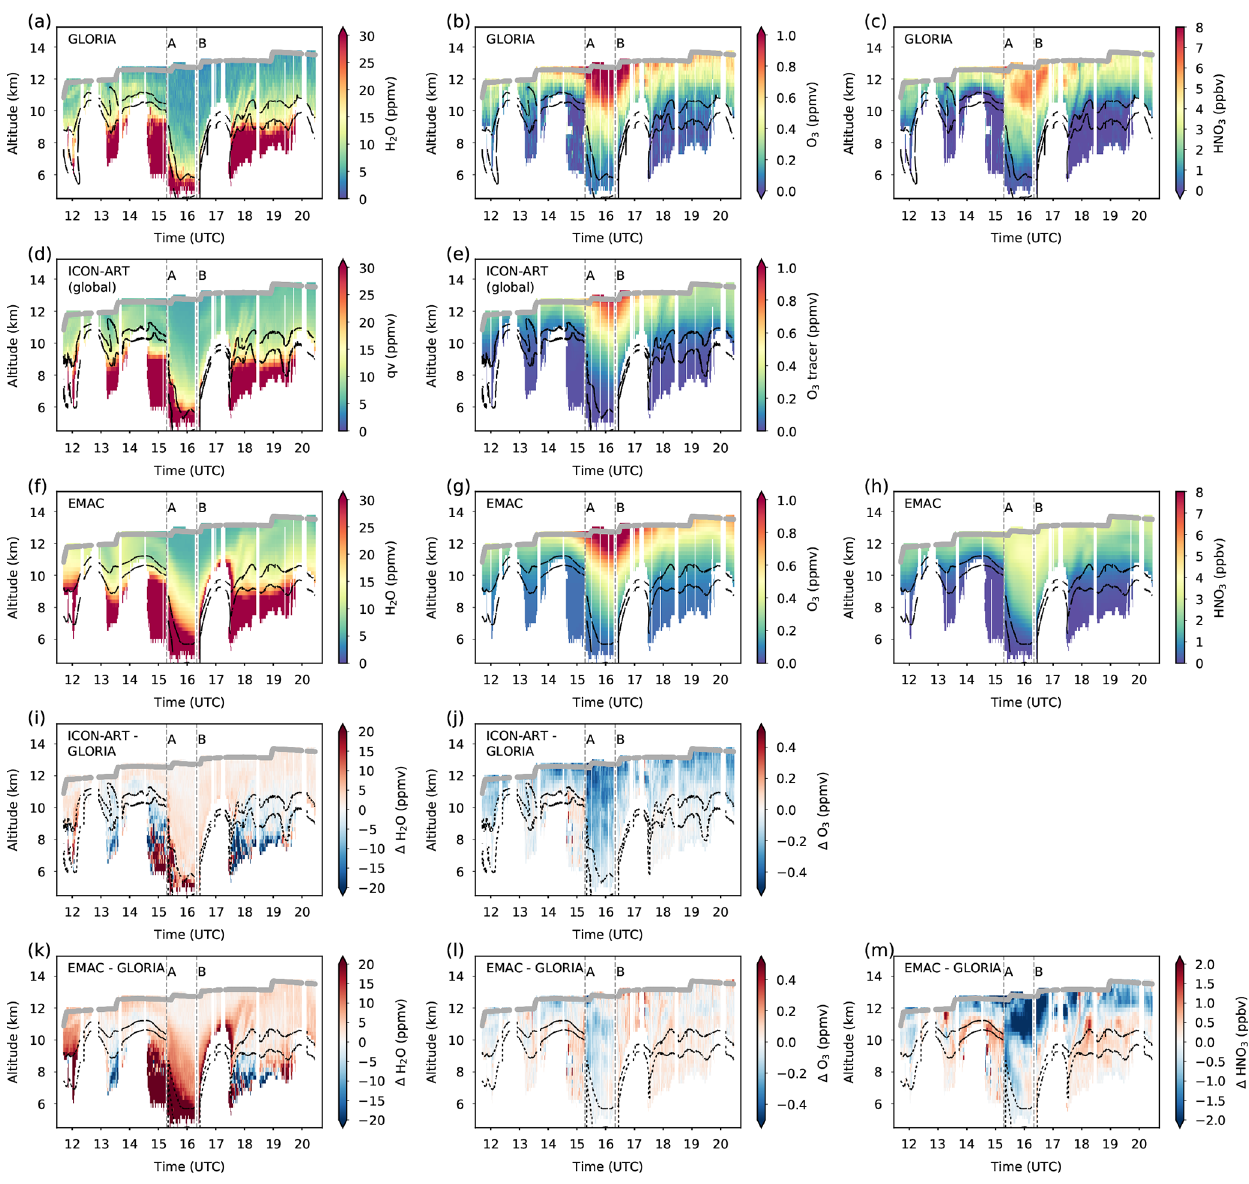
Figure 7. Observed and modelled trace gas distributions. GLORIA observations of water vapour, ozone and nitric acid (a–c) . ICON-ART (global R2B6 grid) short-term forecast of specific humidity (d) and free-running simulation of ozone using simplified ozone depletion parameterisation (e) . EMAC free-running simulations of water vapour, ozone and nitric acid (f–h) . Residuals between the shown model data and GLORIA observations above (i–m) . Black lines: 2 and 4PVU isolines (lower and higher lines, respectively) from ECMWF reanalysis (a– c) , ICON-ART (d, e) and EMAC (f–h) as indicators for the dynamical tropopause. Grey lines: HALO flight